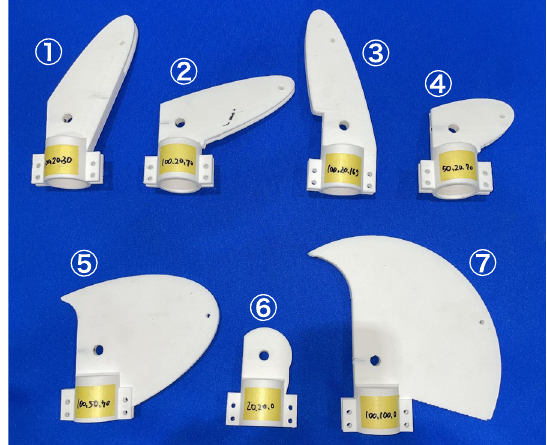
Fig. 11 Seven prototype patellas for the experiment. These were manufactured from PLA using a 3D printer. Patella numbers in the